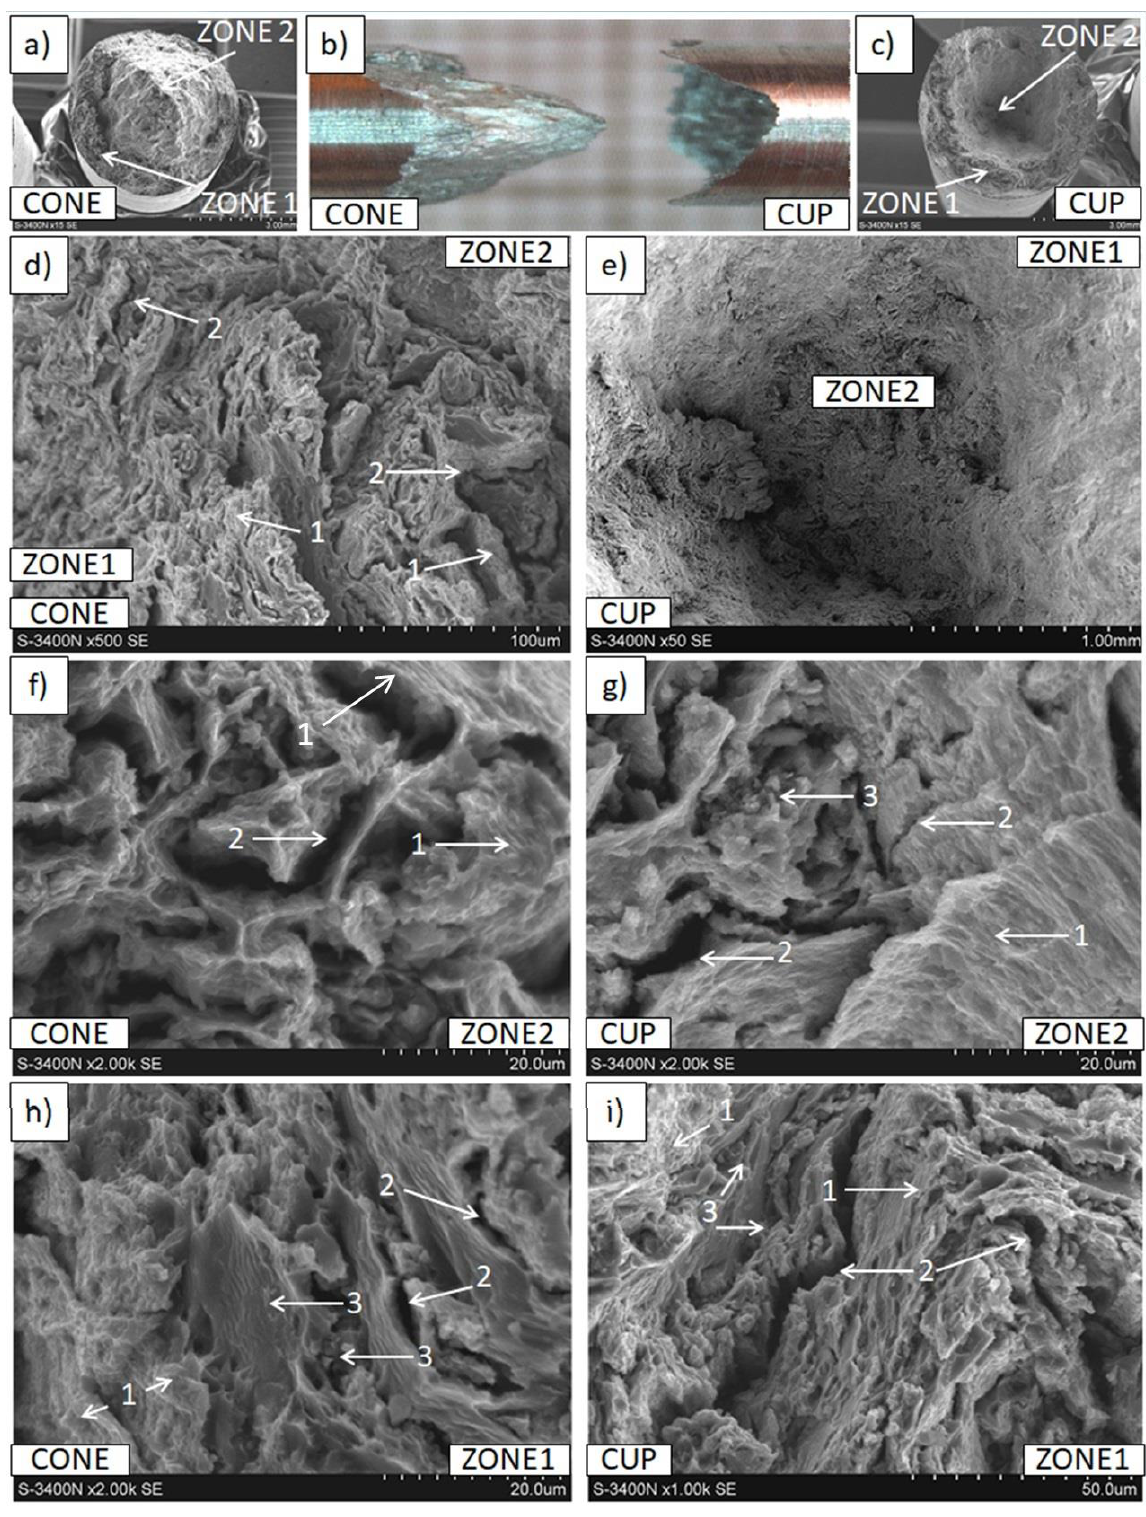
Figure 11. Decohesion effects in Mg(P) rod after tensile strength test. View of sample, fracture of cone and cup type with two zones inside and outside ( a – c ). SEM micrographs of fracture surface ( d – i ) with plastic deformed bands (1), cracks (2), and fine oxides (3).